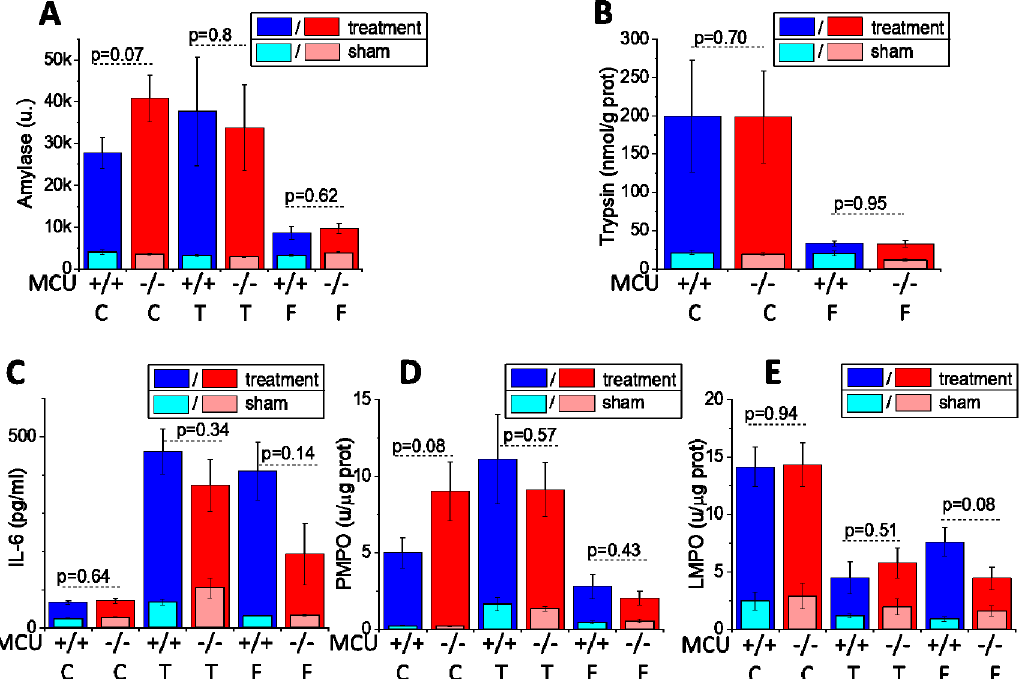
Figure 4. MCU knockout does not reduce biochemical parameters characterizing the severity of acute pancreatitis in CER-AP, TLCS-AP and FAEE-AP. The models of AP are abbreviated on the graph as C for CER-AP, T for TLCS-AP and F for FAEE-AP. The bars indicate the mean values ± the standard errors. In all parts of this figure dark, bars represent the treatment groups, while the light bars represent control (sham) groups (see Materials and Methods Section and text boxes above the bars specifying the color coding). There were no statistically significant differences between the control/sham groups of MCU − / − and MCU +/+ mice in the values of biochemical parameters for any type of control/sham experiments ( p > 0.05). The measured values of the biochemical parameters for all treatment groups were significantly different ( p < 0.05) from the values for the corresponding control (sham) groups. The biochemical markers reflecting the severity of experimental AP are: ( A ) serum amylase; ( B ) pancreatic trypsin activity; ( C ) serum IL-6; ( D ) pancreatic myeloperoxidase activity; and ( E ) lung myeloperoxidase activity. The p values for comparison between MCU − / − and MCU +/+ mice in AP models are indicated above the corresponding bars. In this part of the study, 12 MCU − / − and 13 MCU +/+ mice were used for the CER-AP (with exception of pancreatic trypsin measurements for CER-AP, which were recorded on 7 MCU − / − and 7 MCU +/+ ); 7 MCU − / − and 10 MCU +/+ for the TLCS AP; and 8 MCU − / − and 6 MCU +/+ for the FAEE-AP.